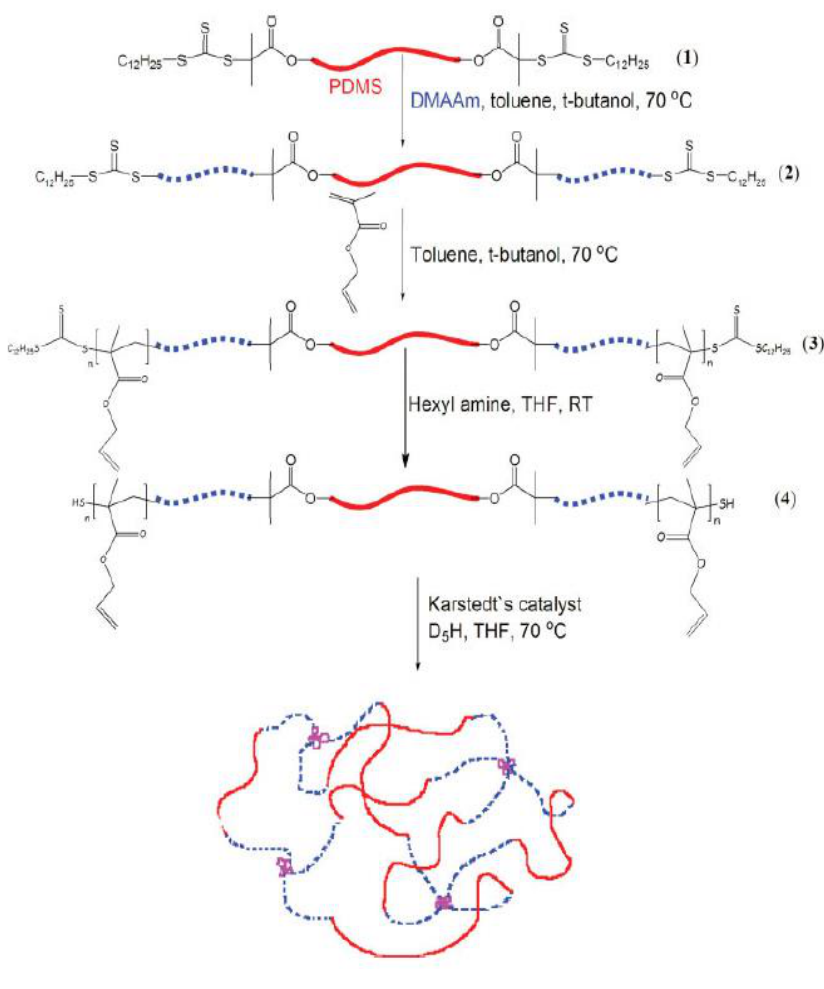
Figure 1. Strategy for the synthesis of APCN [4].